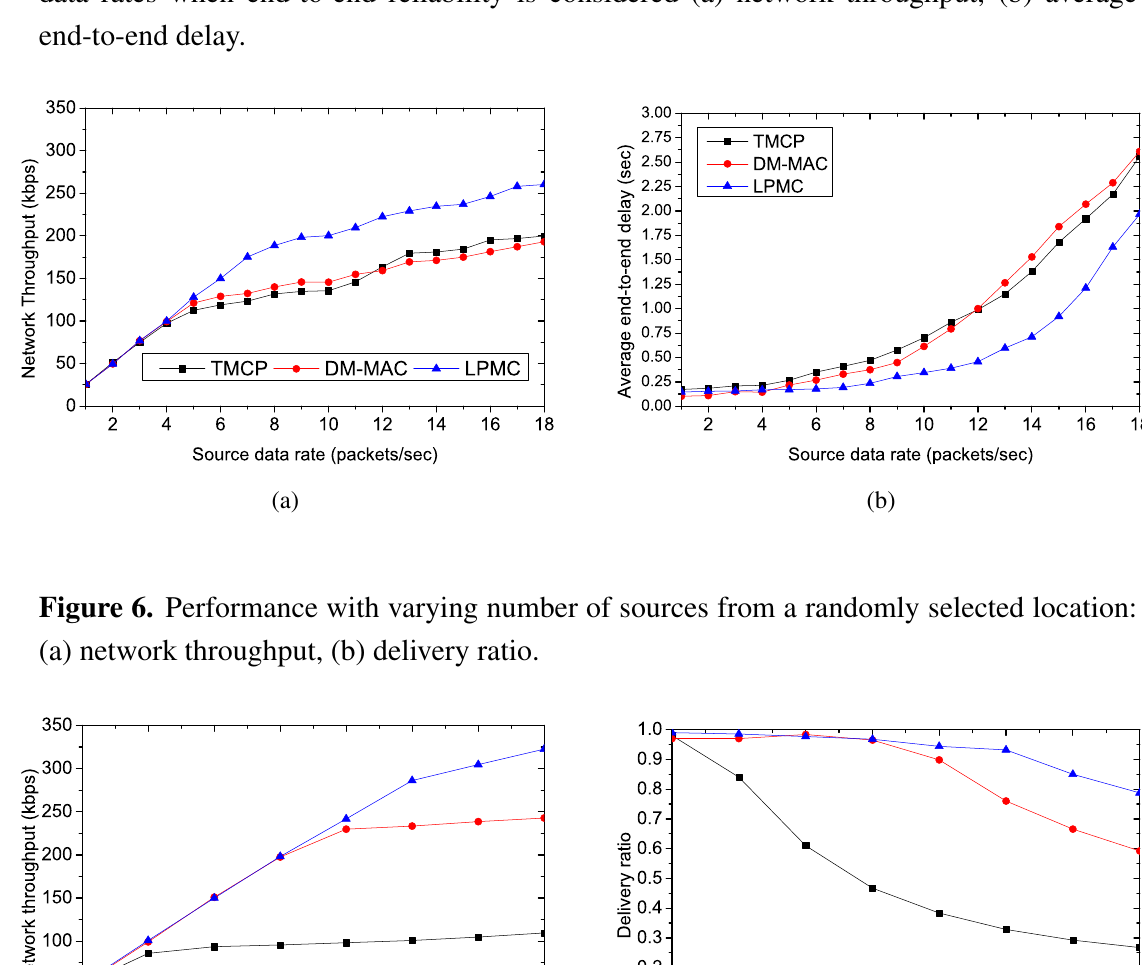
Performance comparisons for randomly selected 50 sources with different data rates when end-to-end reliability is considered (a) network throughput, (b) average